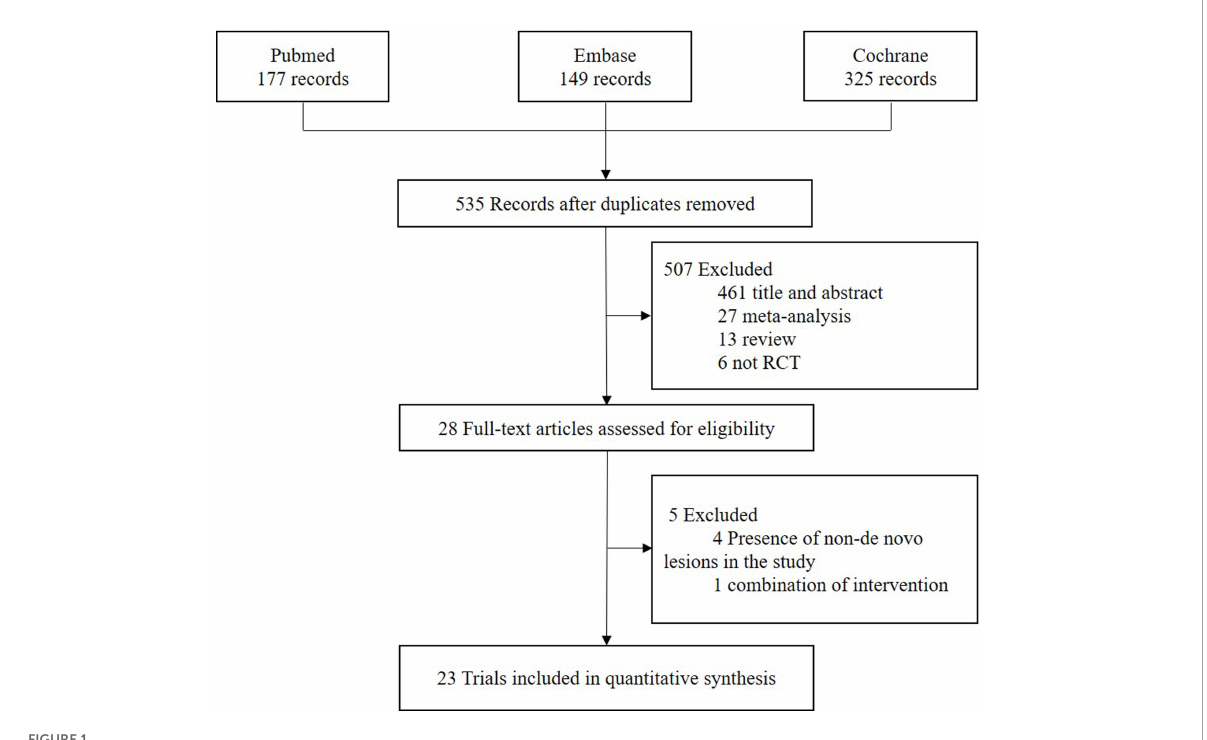
FIGURE1 Flowchart of study